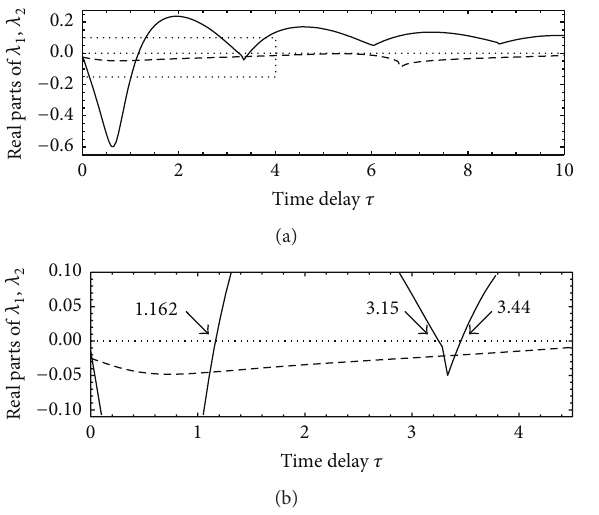
Figure 5: (a) is the real parts of eigenvalues under different time delay and (b) is the square region in (a).